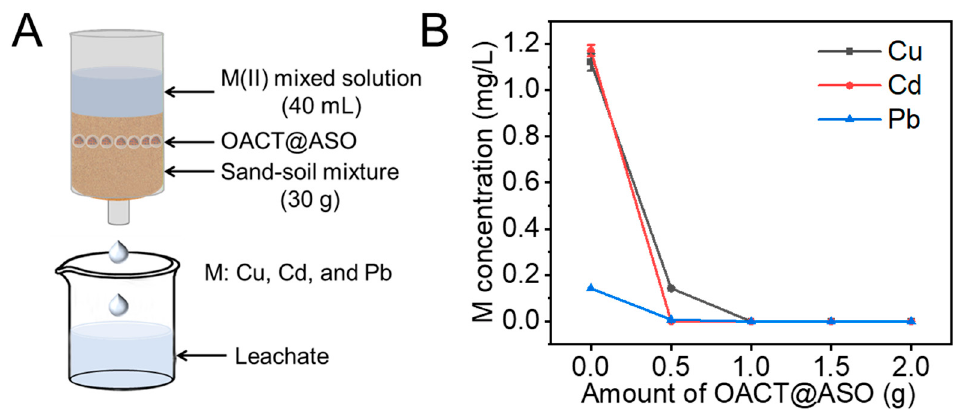
Figure 4. ( A ) Schematic diagram of leaching system. ( B ) Effect of OACT@ASO amount on Cu, Cd, and Pb concentrations in the leachate.